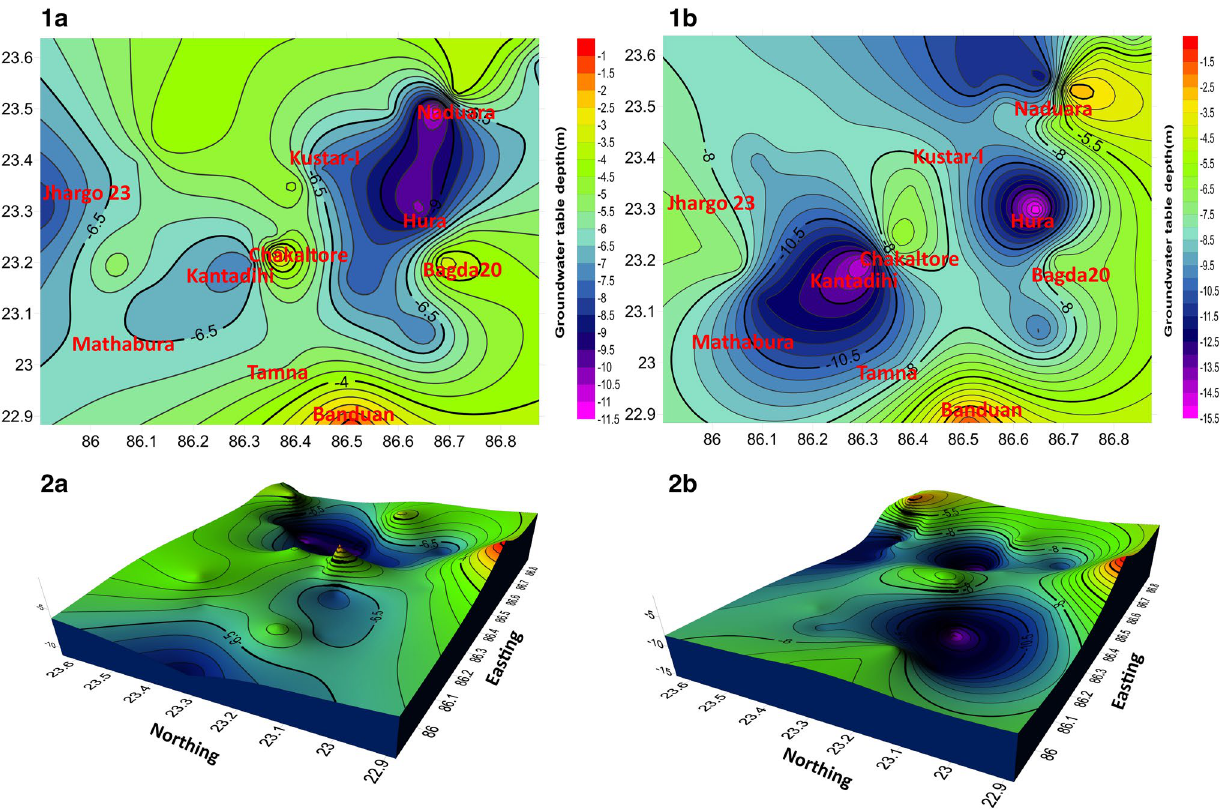
Fig. 10 Illustration of future water depression zones (2040) over Purulia district, 1.a. Post monsoon 1.b. Pre monsoon 2.a. 3d representation of post monsoon groundwater level 2.b. 3d representation of pre monsoon groundwater